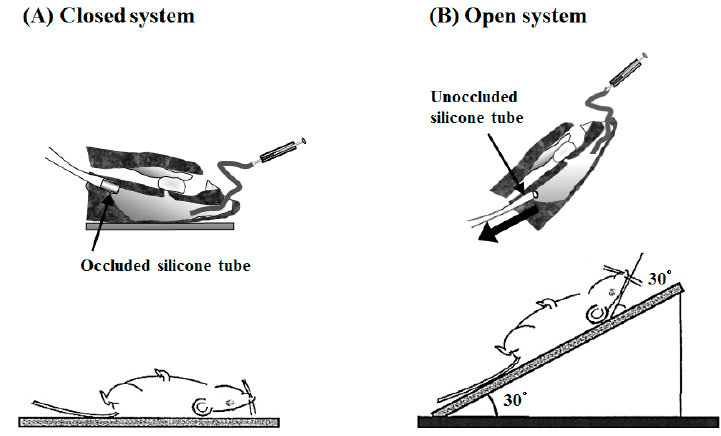
Figure 8. In vivo intranasal ( i.n. ) retentivity evaluation system: closed ( A ), and open ( B ), systems.